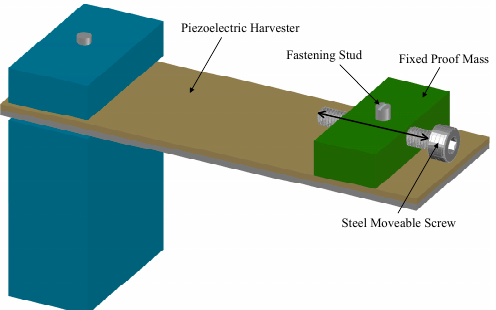
Figure 23. Schematic representation of the variable center of gravity based MTT proposed in [43].